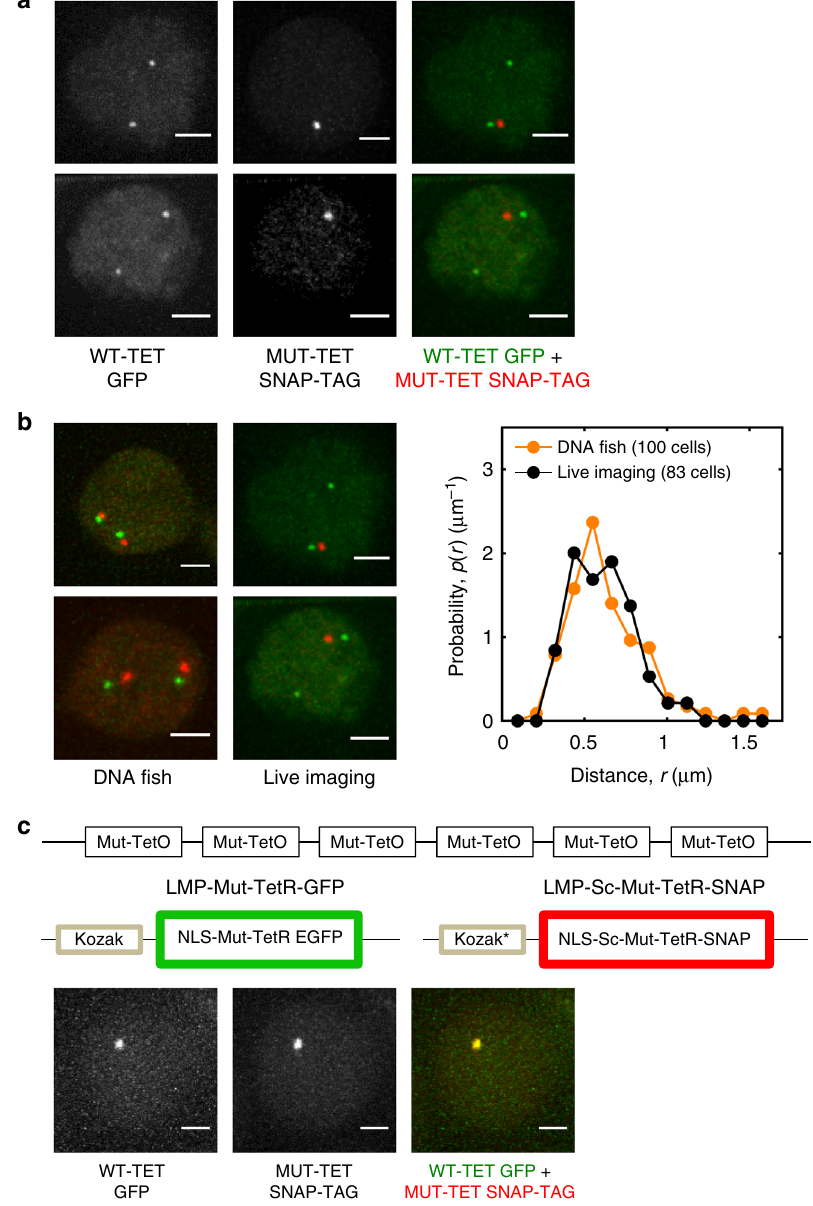
Fig. 2 Tracking V H -D H J H motion in pro-B cells. a Live imaging of pro-B cells harboring D H J H WT-TET and V H MUT-TET alleles. Panels indicate pro-B cells carrying D H J H WT-TET and V H MUT-TET alleles transduced with WT-TET GFP and MUT-TET SNAP-TAG. Left panels display pro-B cells transduced with virus expressing WT-GEP. Middle panels show pro-B cells transduced with virus expressing MUT-TET SNAP-TAG. Right panels show pro-B cells transduced with WT-GFP and MUT-TET SNAP-TAG. Scale bar corresponds to 2 μ m. b Left panels show pro-B cell lines harboring tandem arrays of WT- TET GFP and MUT-TET SNAP-TAG analyzed using 3D-FISH. Fluorescently labeled V H and D H J H probes were used for visualization. Middle panels show fl uorescent foci obtained from live-cell imaging. Right panel shows the probability distributions of spatial distances separating the V H and D H J H elements obtained from live pro-B cell imaging (black dots) compared to those obtained from 3D-FISH measurements (orange dots). Numbers of cells that were analyzed is indicated. c Experimental strategy is displayed to determine localization error. Localization error was determined by measuring the spatial distances separating red and green fl uorescent signals. Fifty cells were analyzed. Scale bars represents 10 μ m. Source data are provided as a